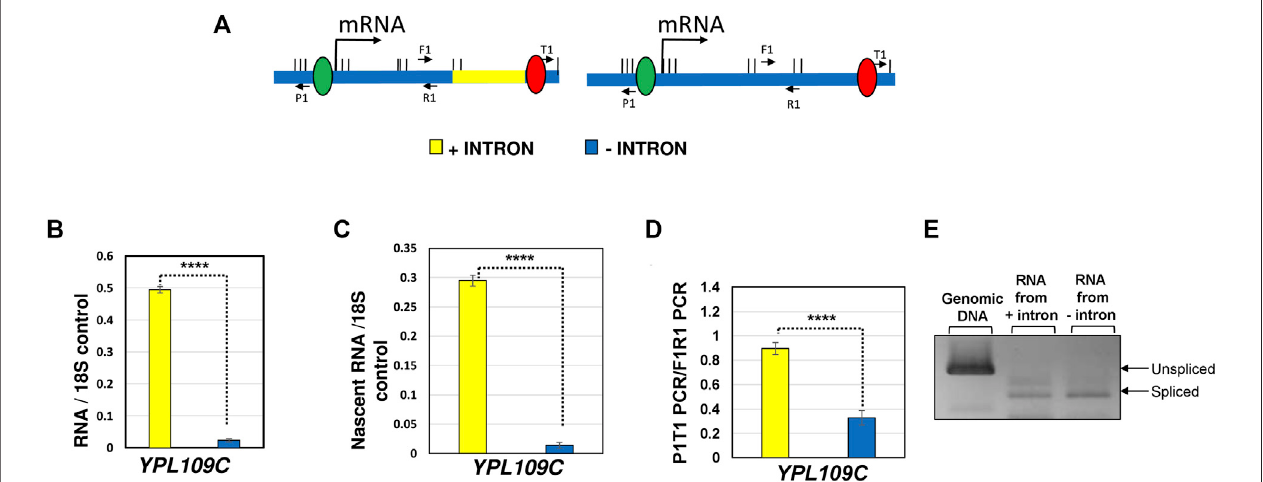
FIGURE1| Deletionoftheterminator-proximalintronof YPL109C reducesboththetranscriptionand loopedconformationofthegene. (A) Schematicdepictionof YPL109C with the intron present (yellow) and intron deleted (blue) indicating the position of primers used for RT-PCR, TRO and 3C analyses. (B) Quanti fi cation of total RNA level of YPL109C measured by RT-PCR approach in the presence of the terminator-proximal intron (yellow bar) and the absence ofintron (blue bar). The 18S RNA signal was used as a normalization control. (C) Quanti fi cation of nascent RNA level of YPL109C measured by TRO approach in the presence of the terminator- proximal intron (yellow bar) and the absence of intron (blue bar). The 18S RNA signal was used as a normalization control. (D) Gene looping of YPL109C measured in termsofP1T1PCRsignalby3Capproachinthepresence(yellowbar)andabsence(bluebar)ofanintron.TheF1R1PCRrepresentstheloadingcontrolthatwasusedto ensure equal amounts of template DNA were present in each 3C PCR reaction. The values and error bars for each condition indicate the mean ± standard deviation. Statistical signi fi cance ( p -values) was determined using the two-tailed paired Student ’ s t -test. Four asterisks (****) indicate p value smaller than 0.0001 ( p ≤ 0.0001). (E) RT-PCR analysis of YPL109C mRNA in the construct with intron (+ intron) and without intron ( − intron). Genomic DNA PCR of intron-containing strain indicates the position of unspliced transcripts. The expected positions of spliced and unspliced transcripts obtained by RT-PCR approach for each construct is indicated.